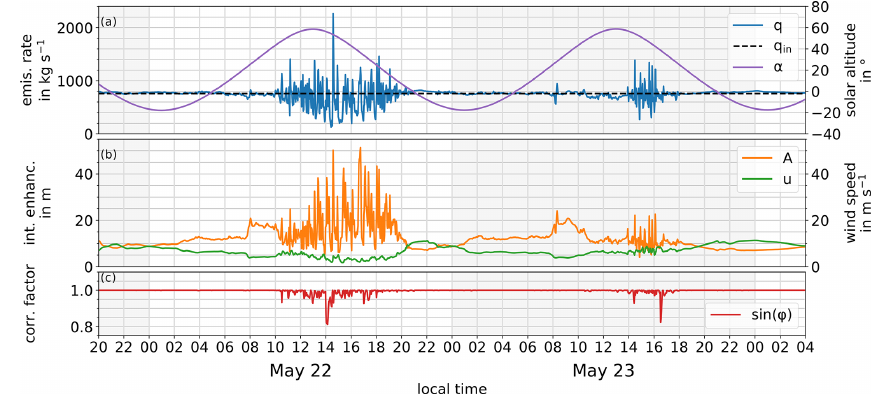
Figure 8. Virtual overflight results in the course of the day. In (a) it can be seen that rising solar altitude α entails turbulence. Especially midday turbulence causes deviations in the retrieved emission rate q from the input emission rate q in . In (b) the integrated enhancement A shows equivalent behavior, while the variations in wind speed u are comparatively small. It is during the midday turbulence that the virtual flight tracks are not exactly perpendicular to the instantaneous wind direction at the plume crossing, which becomes apparent in the correction factor sin (ϕ) in (c) . In the night hours, as well as the morning, the retrieved emission rates agree very well with the input emission rate q in . The wind speed u surpasses the threshold value of 2ms − 1 at all times.